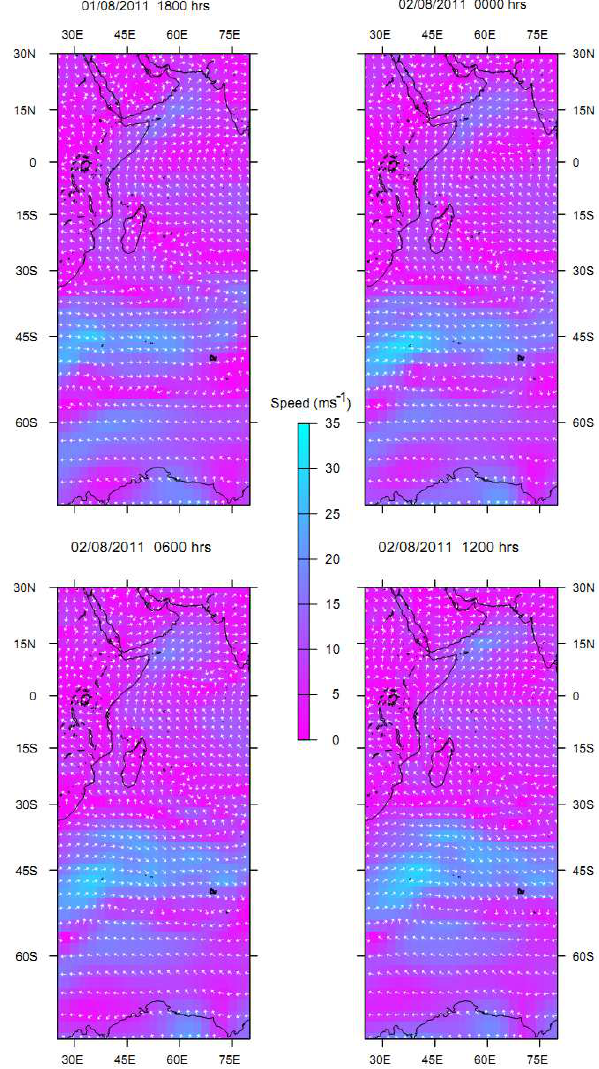
Fig. 6. Seasonal and annual composite image of NCEP wind over Figure 6: Composite image of NCEP wind western Indian Ocean during 2011 489 western Indian Ocean. Figure 7: Southern Ocean and Indian Ocean wind system during 1-2 August showing the 491